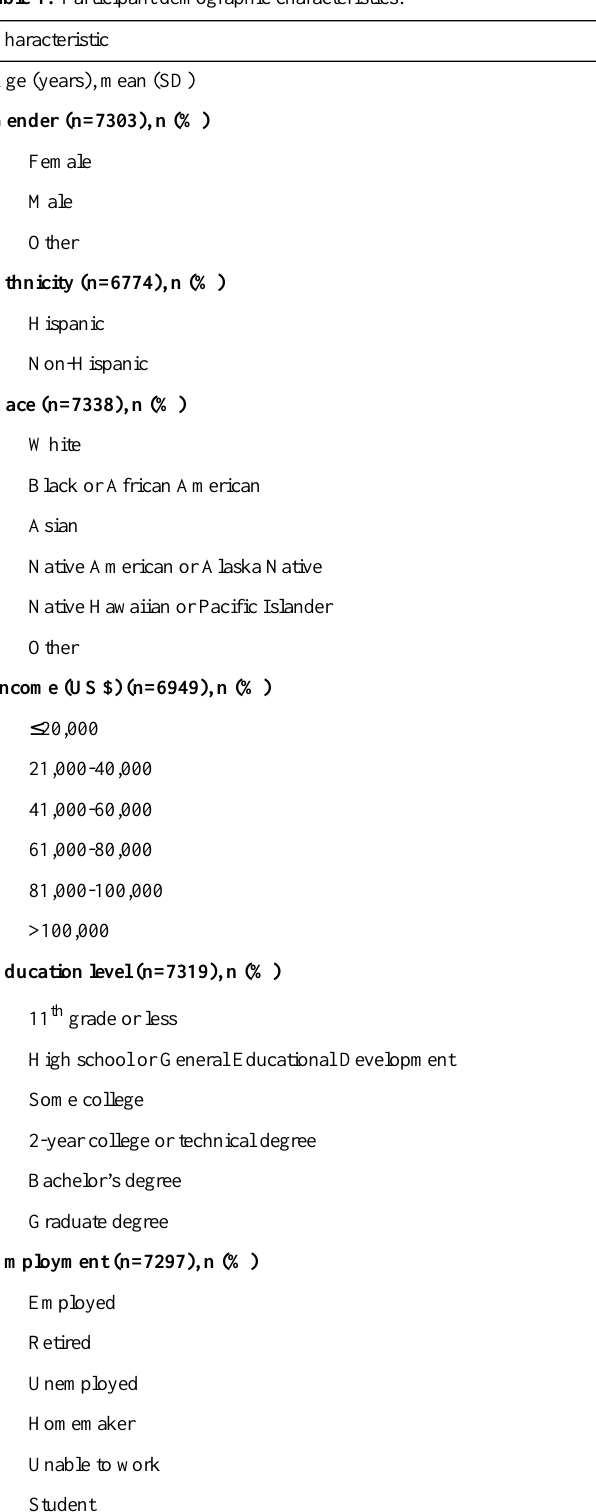
Table 1. Participant demographic